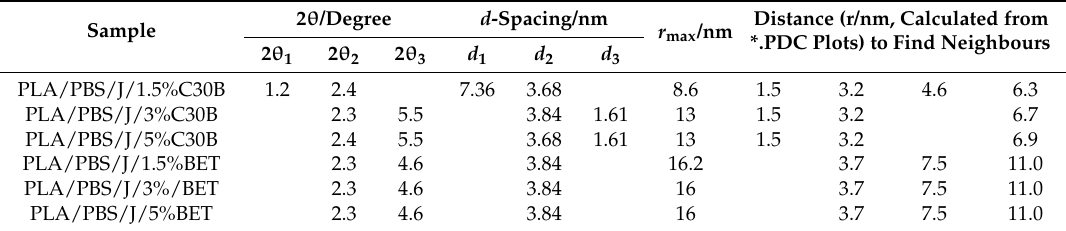
Table 2. Results from SAXS analysis for various blend nanocomposite